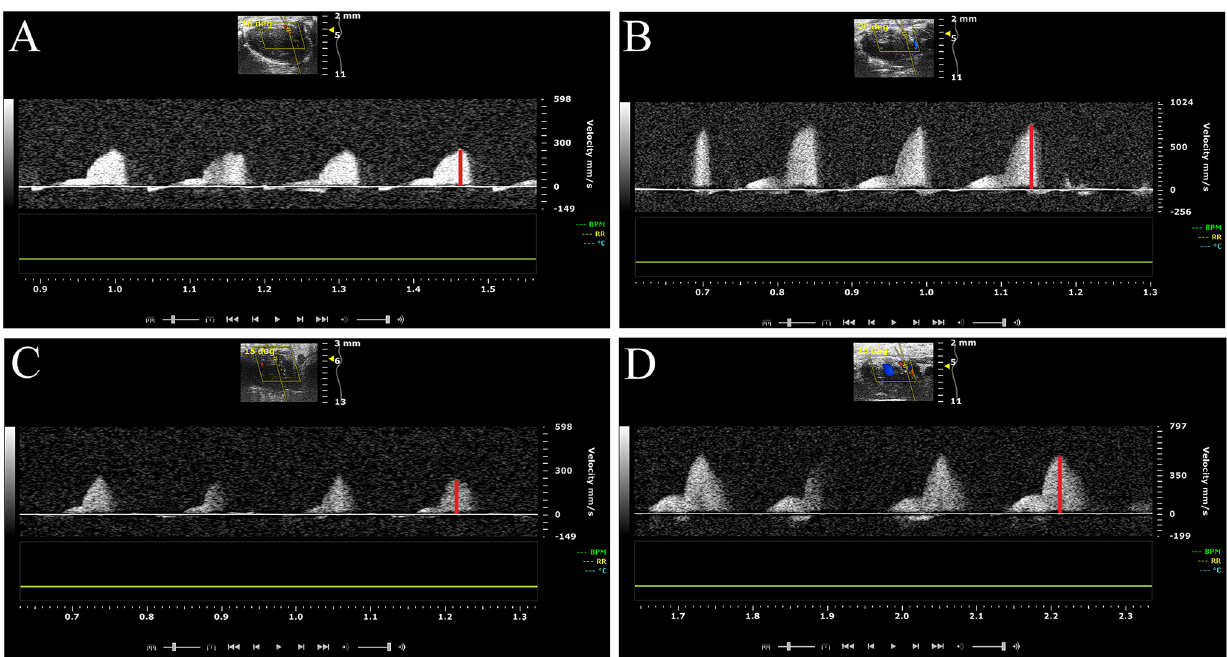
Fig 1. Representative color Doppler image for measurement of coronary flow Velocities. Typical recordings of resting and hyperaemic flow velocity measurement in the left coronary artery were performed with color Doppler ultrasound in lean and leptin-deficient (ob/ob) mice at 10, 16 and 21weeks of age. Hypereamic flow velocity was induced by intravenous infusion of adenosine (140 μ g/kg/min). Coronary flow velocity reserve was calculated as the ratio of peak diastolic flow velocities (red line) before (resting) and during (hyperaemic) adenosine infusion. A: Resting coronay flow velocity in lean mice. B: Hyperaemic coronary flow velocity in lean mice. C: Resting coronary flow velocity in ob/ob mice. D: Hyperaemic coronary flow velocity in ob/ob